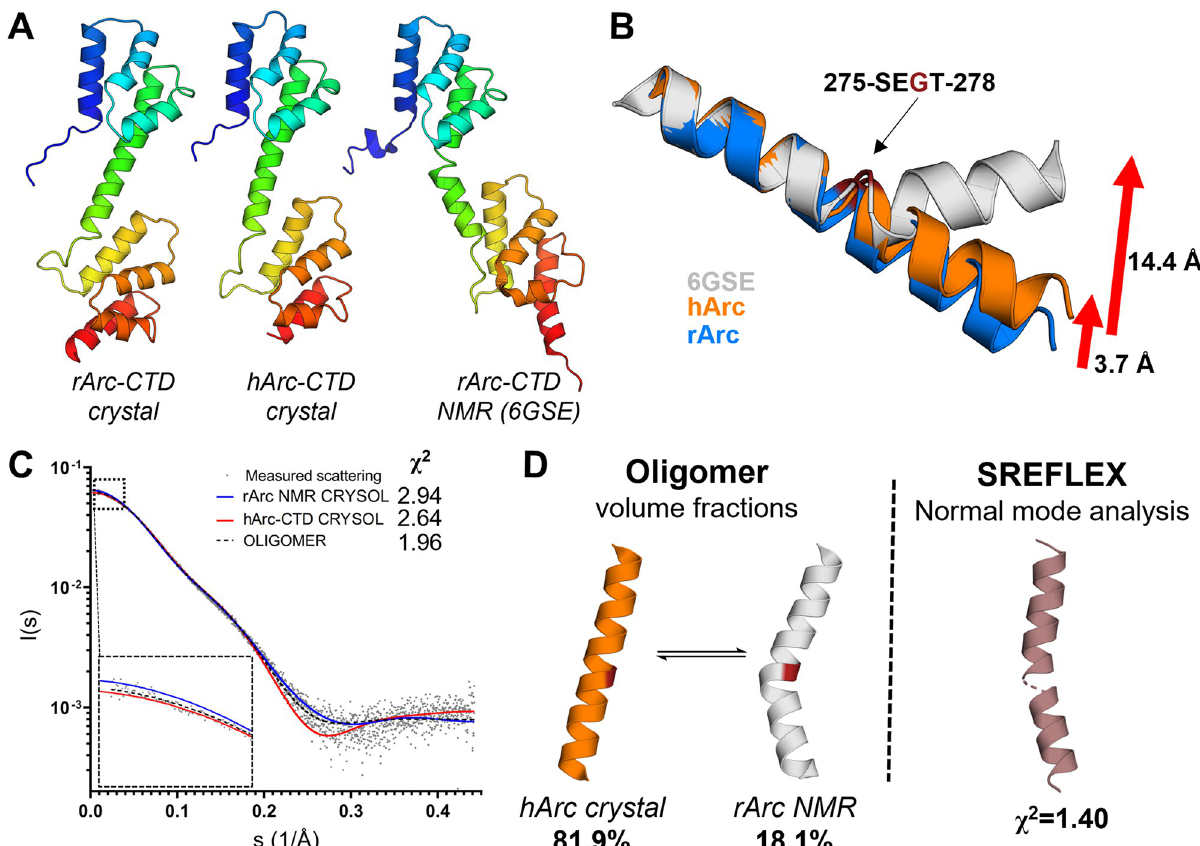
Fig 9. The Arc-CTD is dynamic in structure. A Comparison of the Arc-CTD crystal structures with the NMR model of rArc-CTD (6GSE, [31]) reveals a hinge in the central helix. B Superimposition of the N-terminal end of the helix highlights a hinge at Gly277. C Analysis of the solution structure of the Arc-CTD using SAXS. Shown are the experimental scattering curve of hArc-CTD, theoretical curves for the crystal structure and the NMR model (6GSE, [31]), and the fit from volume fraction. D Central helix conformation and results of volume fraction analysis (left). Normal mode analysis (right) of the hArc-CTD crystal structure against the SAXS data gave an average solution conformer of the central helix. The N- and C-lobes are not shown in panels C and D for clarity.